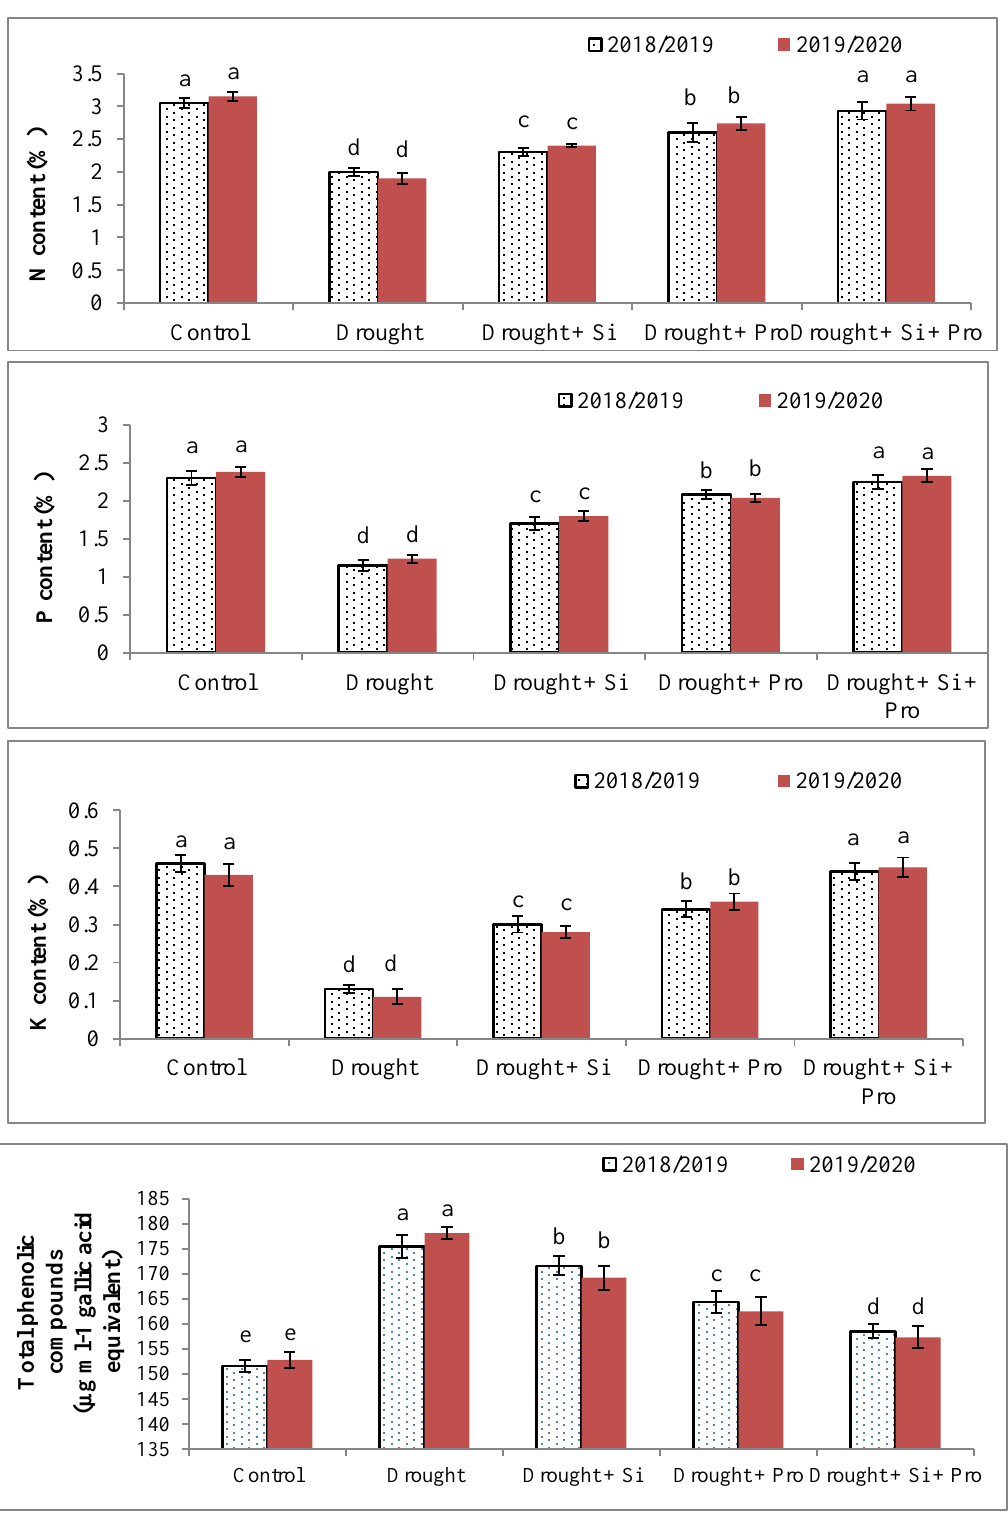
Figure 5. Effect of silicon and proline on nitrogen ( A ), phosphorus ( B ), potassium ( C ) and total phenolic compounds ( D ) of sugar beet plants under drought in the 2018/2019 and 2019/2020